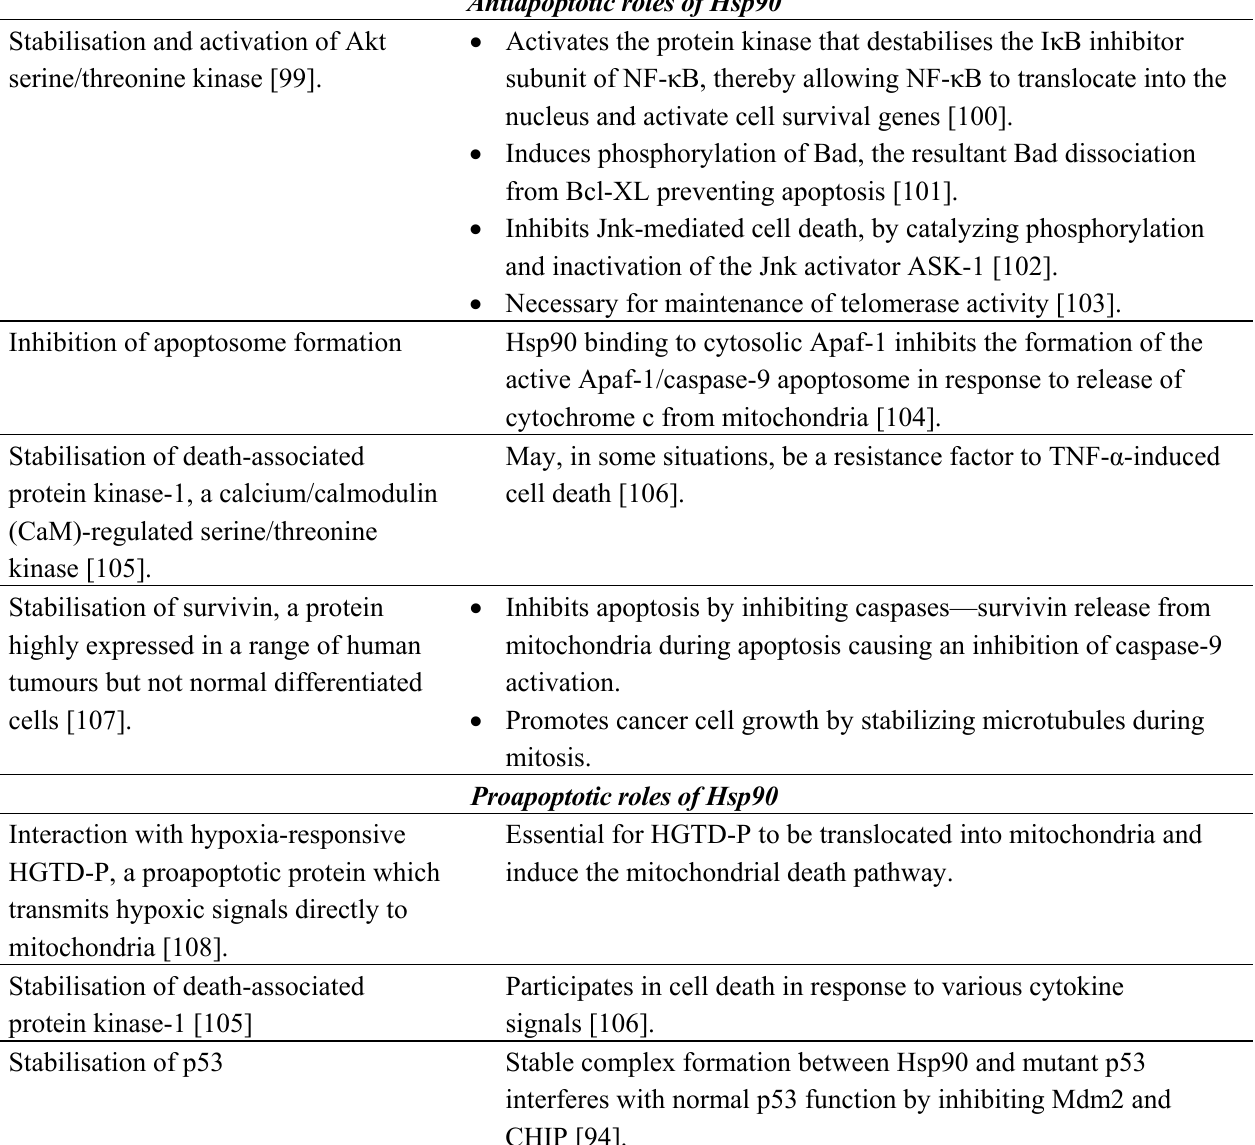
Table 1. Some of the reported involvements of Hsp90 in